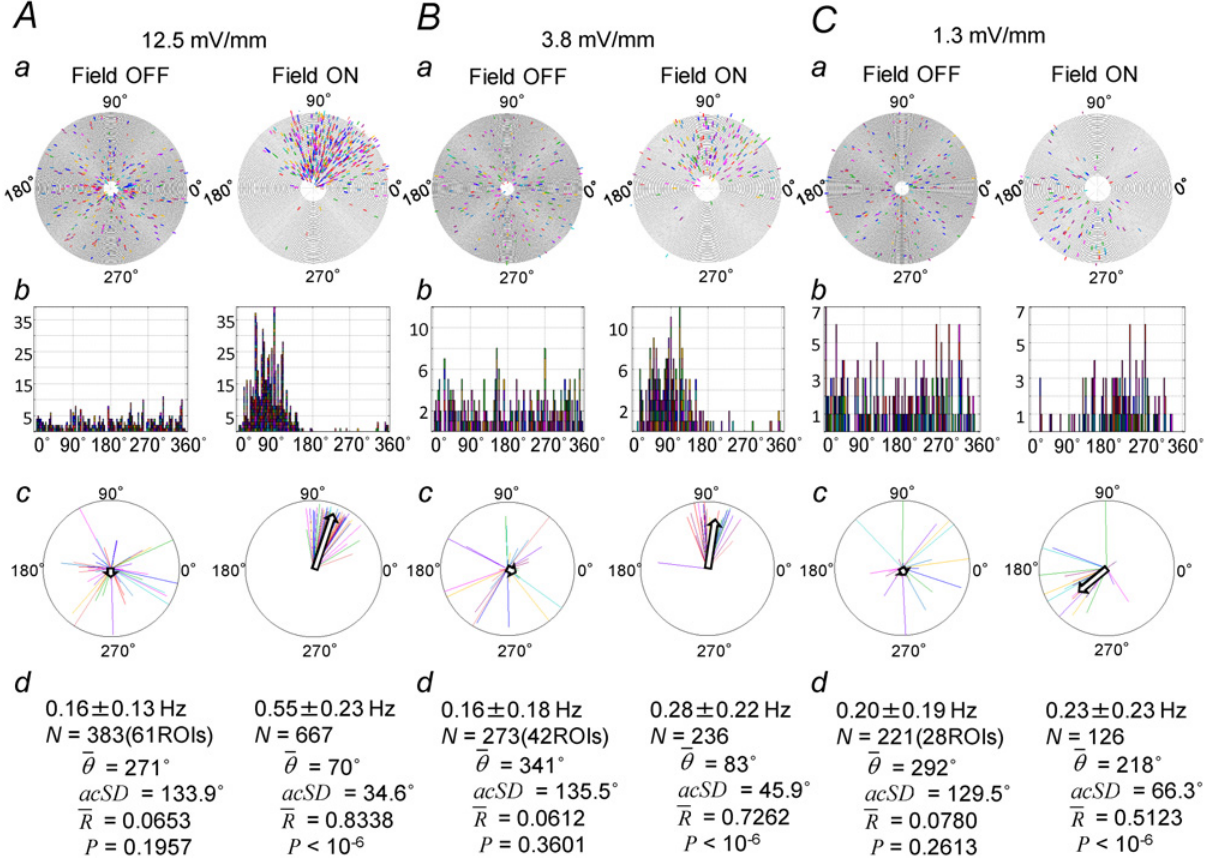
Fig 7. Entrainment of fast-Ca-transients at different field intensities. ( A , B , C ) 4 Hz sinusoidal electric field of three different intensities was applied to the same slice preparation in ACSF/4-AP containing 6.5 mM K + ion. Image recording was made from the distal apical dendrites with a frame interval of 16.4 msec. Analysis of data obtained in experiments with a field intensity of 12.5 mV/mm ( A ), 3.8 mV/mm ( B ), or 1.3 mV/mm ( C ) are shown. Top panels ( a ): Spiral plots. The right panels show data recorded during the period in which the field stimulation was applied (Field ON) and the left panels for the period with no applied field (Field OFF). Note that the fast-Ca-transients were entrained to the applied field even at the field intensity of 1.3 mV/mm. Upper middle panels ( b ): Phase distribution histograms for the data shown in ( a ). Bin width 3°. The vertical axis represents number of fast-Ca-transients for the bins of the histogram. The horizontal axis represents the phase in terms of angular degree. Lower middle panels ( c ): Circular diagrams constructed for the same set of data showing mean resultant vectors. The colored lines represent the mean resultant vectors for the Ca-transients recorded from each of the ROIs and the arrows represent the mean resultant vector for the Ca-transients recorded from all the ROIs (see Methods). Bottom panels ( d ): Statistical values for all the fast-Ca- (cid:1) y (cid:1) ), circular standard deviation in terms transients recorded from all the ROIs; frequency of the Ca-transients, total number of the transients ( N ), mean phase ( (cid:1) R (cid:1) of angular degree ( acSD ), mean resultant length ( ), and the significance probability for the null hypothesis of uniform circular distribution ( P